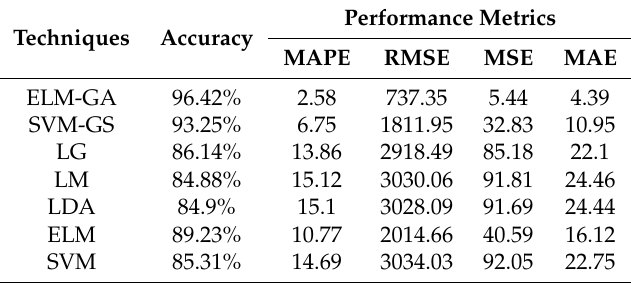
Table 2. Proposed and SOTA techniques results.